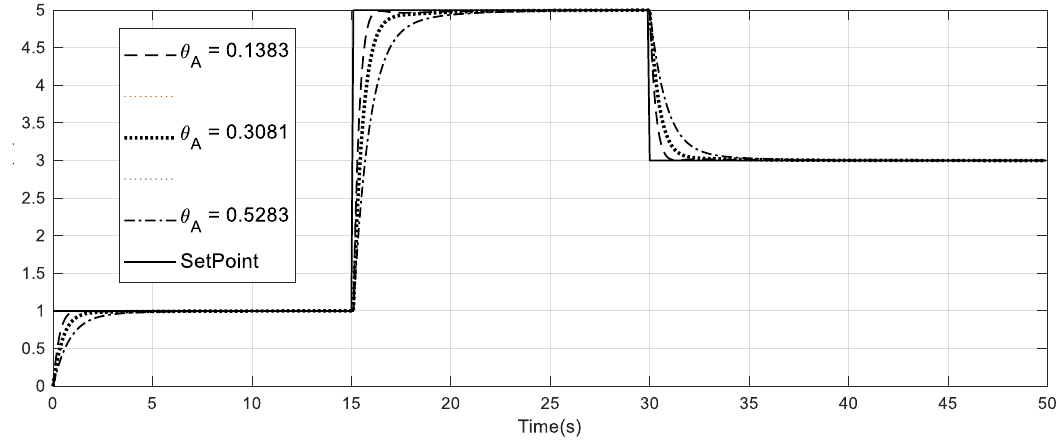
Figure 18. Response to Tool III for changing the θ A parameter.